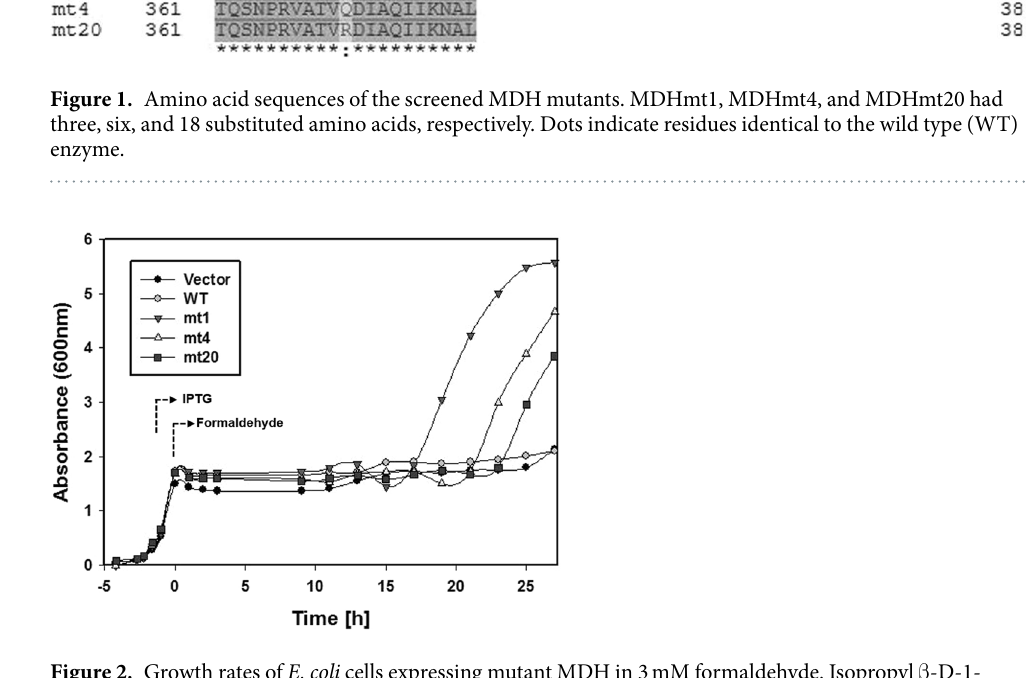
Figure 2. Growth rates of E. coli cells expressing mutant MDH in 3 mM formaldehyde. Isopropyl β -D-1- thiogalactopyranoside (IPTG) was added at an OD 600 of 0.6 to induce MDH expression, and after 1 h, 3 mM formaldehyde was added. Vector, negative control with no mdh gene; WT, wild type mdh gene; mt1, MDHmt1 gene; mt4, MDHmt4 gene; mt20, MDHmt20